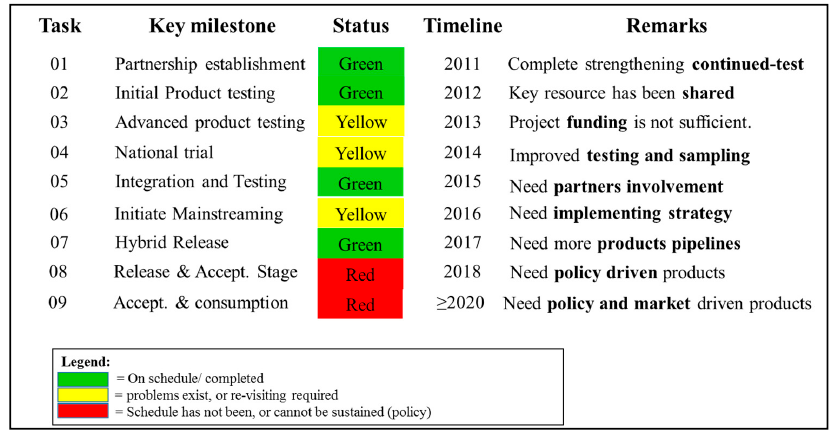
Figure 5. Snap-shot of the pearl millet biofortification program challenges and opportunities in developing countries (India and Africa).